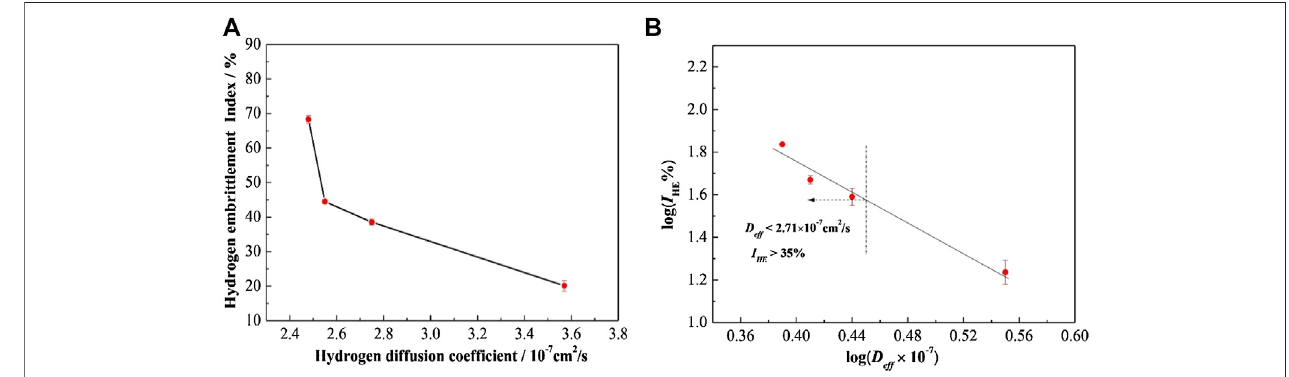
FIGURE 14 | Effect of the hydrogen diffusion coef fi cient on the embrittlement index of DP steels: (A) experimental dates; and (B) logarithmic values.